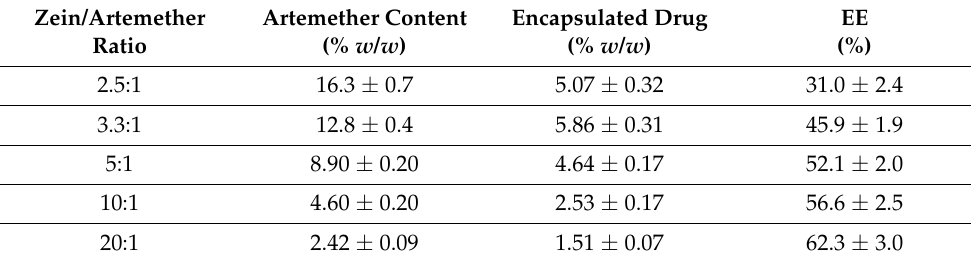
Table 1. Artemether content and Encapsulation Efficiency (EE)